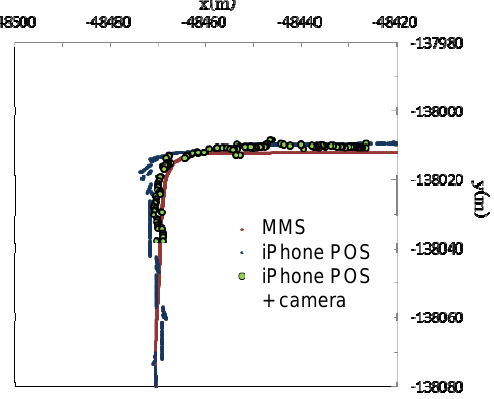
Figure 10. Result of position with all sensors